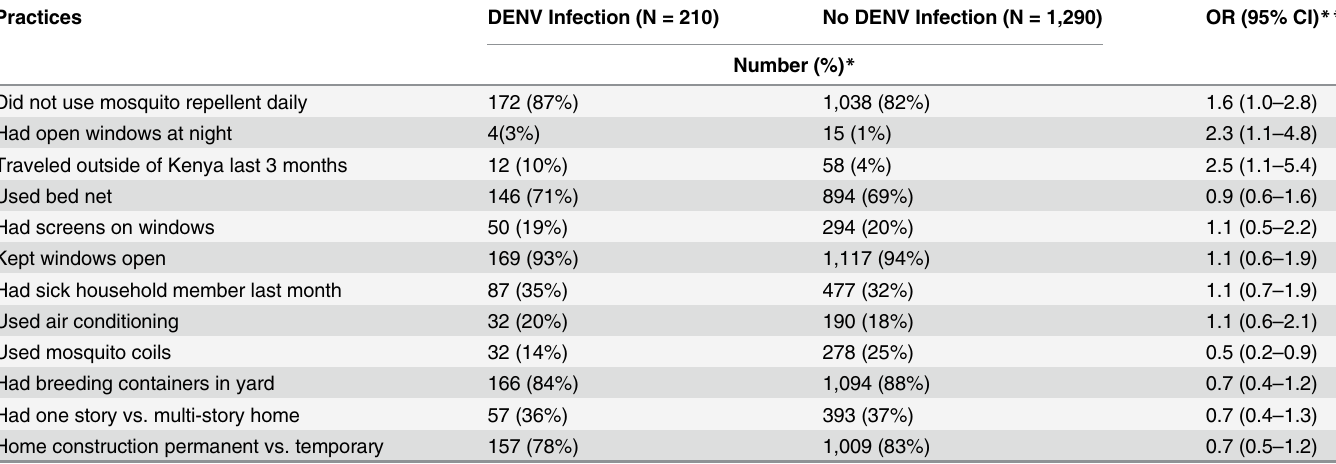
Table 2. Risk factors associated with dengue virus infections (DENV) among residents of Tudor, Mombasa, Kenya, May